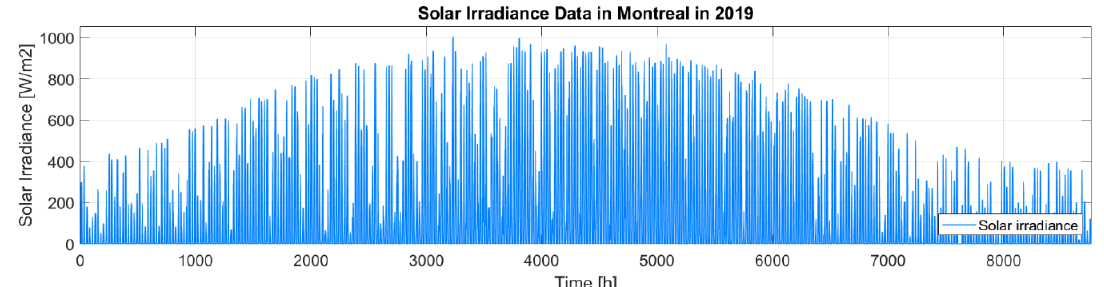
Figure 2. Ambient temperature data in Montreal for the year 2019.